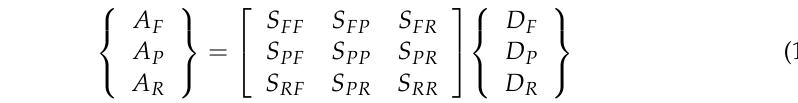
Figure 6. Nonlinear steel stress–strain relationship.